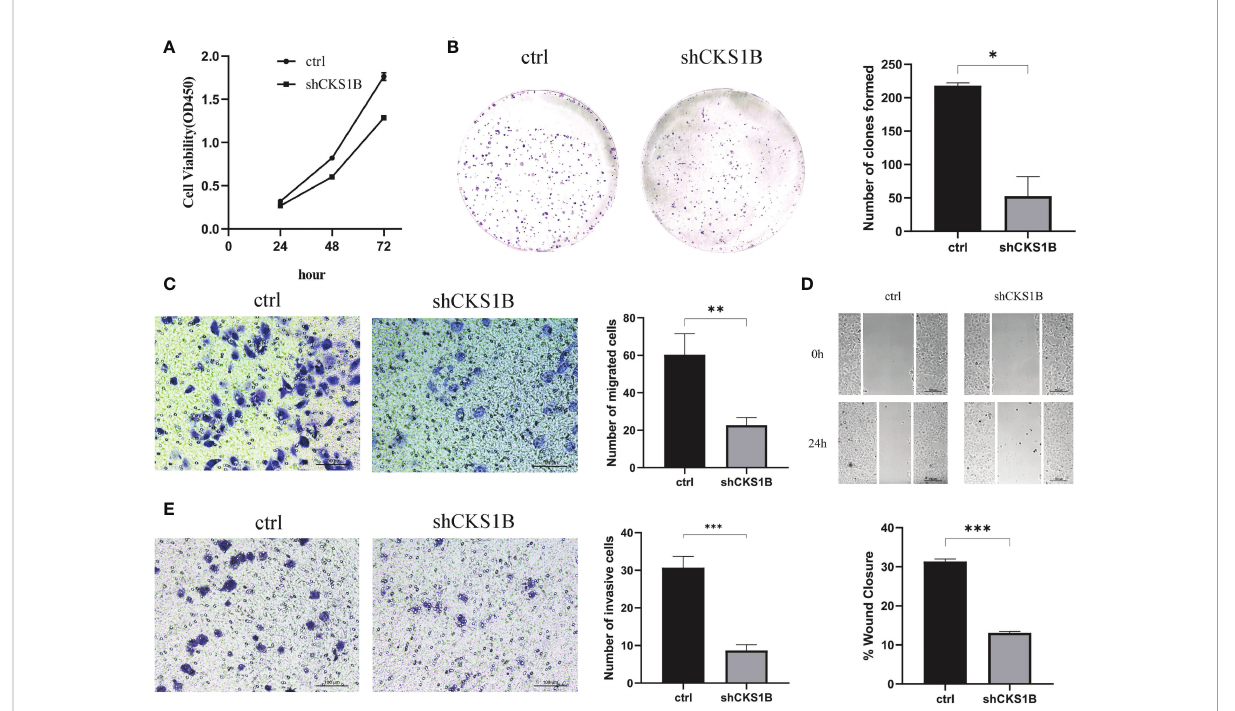
FIGURE 9 CKS1B promotes cell proliferation, migration and invasion in pancreatic cancer. (A, B) Cell viability of different groups of cells was measured by CCK8 assay (A) and colony formation assay (B) . (C, D) Cell migration ability of different groups of cells was detected by transwell assay (C) and wound healing assays (D) . (E) Cell invasion ability of different groups of cells was detected by transwell assay.